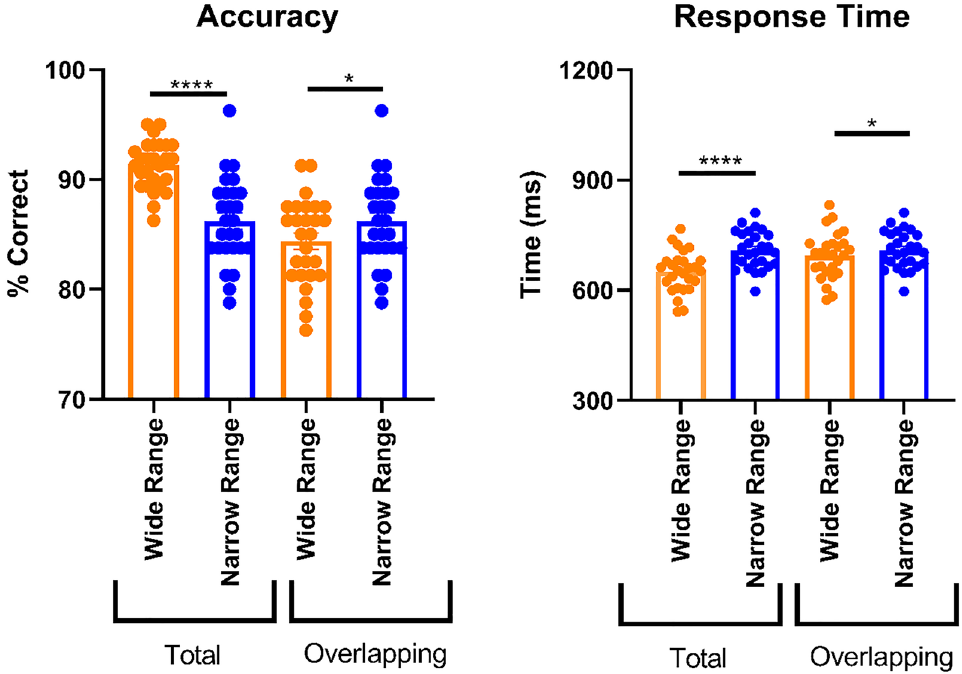
Figure 5. Accuracy and response times from Experiment 3. Conventions as for Experiment 1 (see Fig. 3). * = p < 0.05, **** = p <